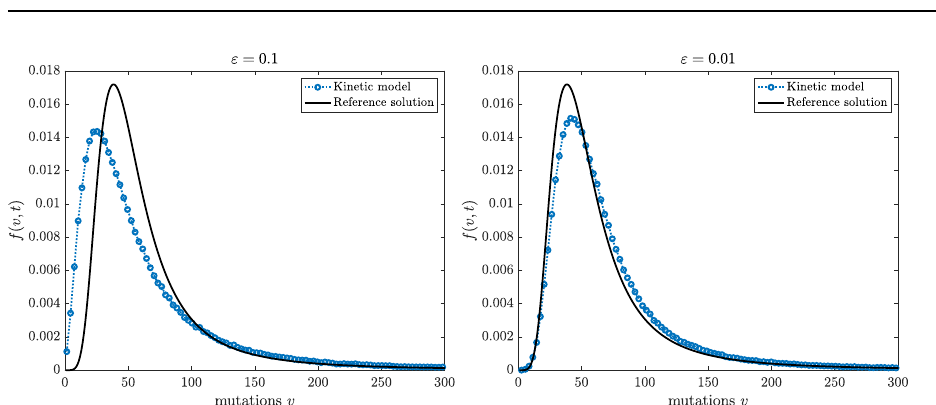
Figure 1. Luria–Delbrück case. Distribution of mutant cells at T f = 6.7 with β 1 = 3, β 2 = 2.5 for ε = 0.1 ( left ) and ε = 0.01 ( right ) in the kinetic model (18) under scaling (33), with L ( v ) = β v . The reference solution is computed using Lemma 2 in [18].